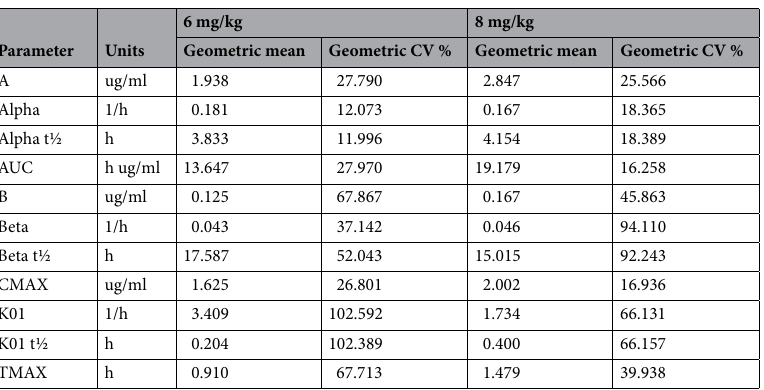
Table 1. Pharmacokinetic parameters for danofloxacin in plasma dosed at 6 mg/kg under the skin every 48 h for two doses and 8 mg/kg under the skin once. A, B, the intercept for the initial and terminal portions of the curve, respectively. Alpha (α) and beta (β) are the rate constants for the initial and terminal portions of the curves, with their respective half-lives (t½). K01 is the absorption rate and corresponding half-life (t½). C MAX maximum drug concentration, T MAX time to maximum drug